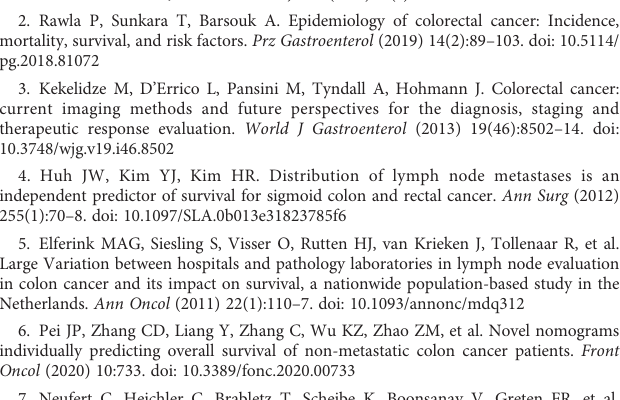
SUPPLEMENTARY FIGURE 1 The mutation of LRP2 mRNA in different groups of samples, in which the horizontal axis represents the samples of different groups, the vertical axis represents the distribution of the mRNA mutation, where different colors represent different mutation types, and the right side represents signi fi cance, P value is the test